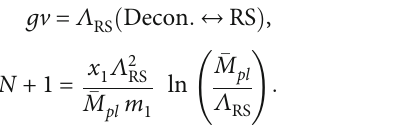
Figure 7: Comparison between the RS (dashed-blue line) and the CW (solid-orange line) models in the matching region. For this plot, we chose m = 2000 GeV and Λ = 5100 GeV which implies 1 RS ≈ 2390 GeV and k ≈ 1131 GeV. M 5 CW CW